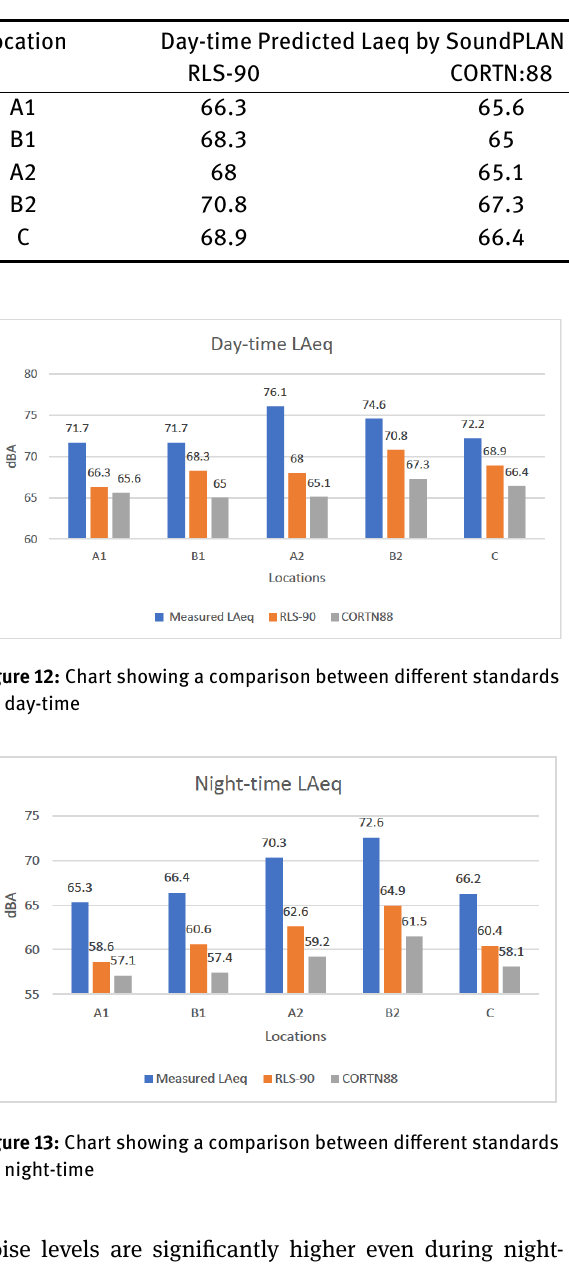
noise levels are significantly higher even during